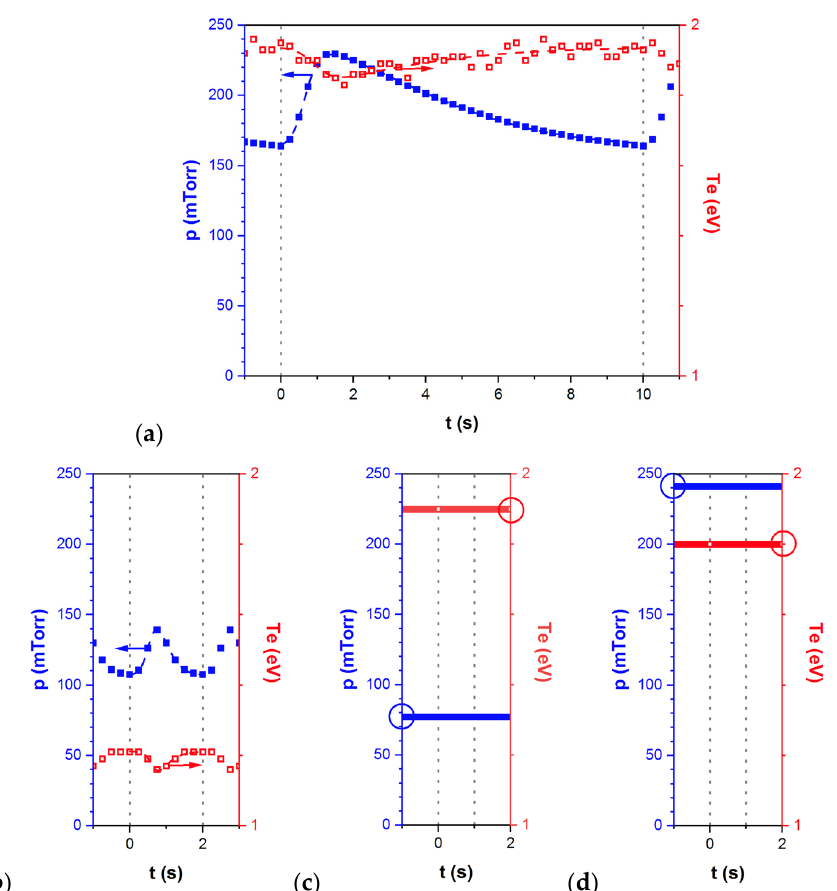
Figure 8. ( a ) Evolution of the pressure (blue curves) and of the electron temperature (red curves) during a pulse for ( a ) f = 0.1 Hz, p 0 ~160 mTorr, Δ p ~70 mTorr, ( b ) f = 0.5 Hz, p 0 ~110 mTorr, Δ p ~30 mTorr, ( c ) f = 1 Hz, p 0 ~70 mTorr, Δ p < 1 mTorr, and ( d ) f = 1 Hz, p 0 ~240 mTorr, Δ p < 1 mTorr.